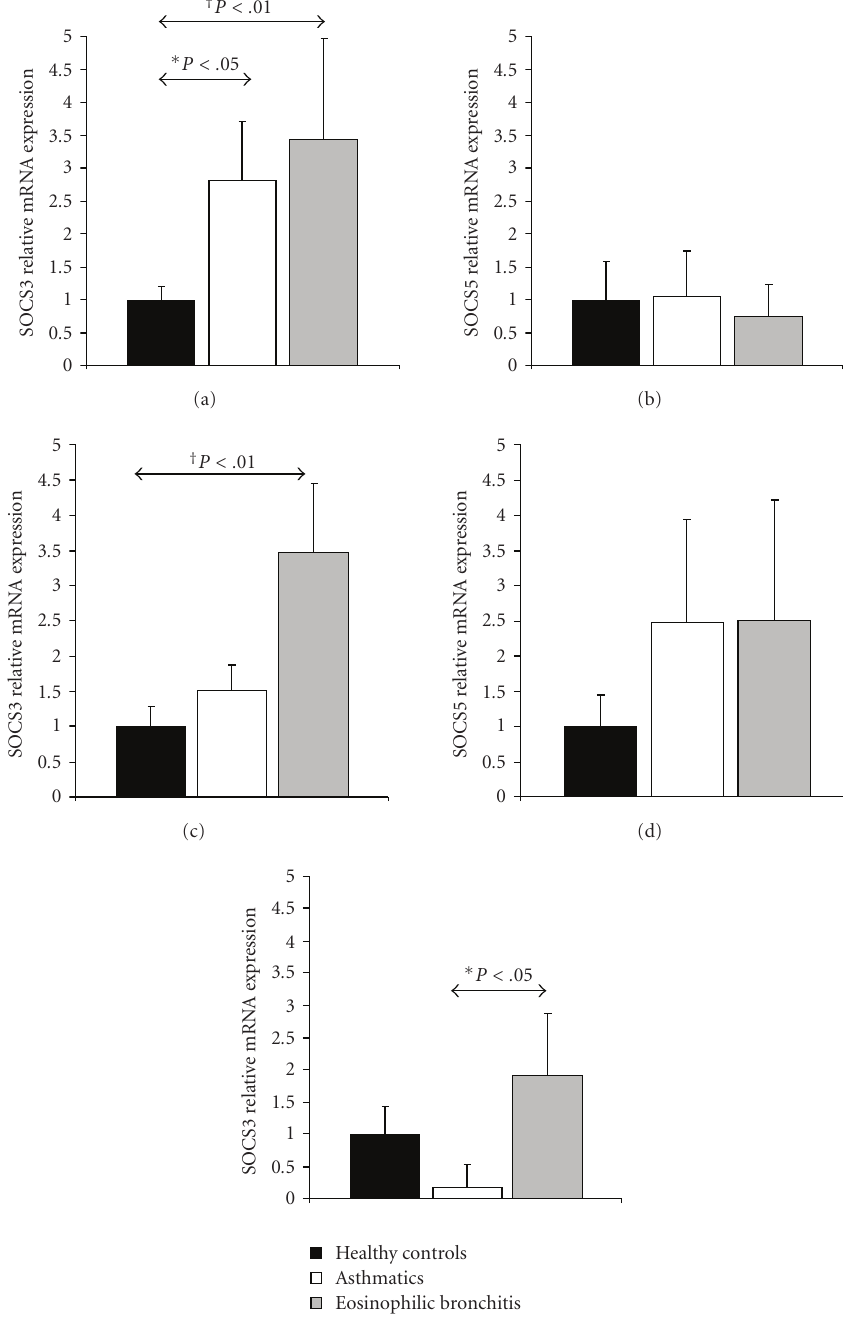
Figure 1: Semiquantitative expression of SOCS3 and SOCS5 genes in peripheral blood purified CD4 T cells and eosinophils. Relative mRNA levels of SOCS3 and SOCS5 in CD4 T cells ((a) and (b)), and eosinophils ((c) and (d)) of healthy controls, asthmatic and NAEB patients were determined by real-time quantitative PCR. Values were normalized with rRNA gene used as an endogen. Black boxes represent the healthy control group (mean ± SD, n = 9), white boxes represent the asthmatic patient group (mean ± SD, n = 6), and lineated boxes represent the NAEB group (mean ± SD, n = 8). Significant di ff erences in the levels of SOCS3 expression in CD4 T cells were obtained for asthmatic and NAEB patients versus the healthy control group ( ∗ P < . 05 and ∗∗ P < 0 . 01, resp.). In eosinophils, the SOCS3 level was significantly higher in NAEB patients than in healthy controls ( ∗∗ P < . 01) . In the case of SOCS5, no significant di ff erences were found between the groups. (e) SOCS3 mRNA levels in bronchial biopsies from healthy controls (mean ± SD, n = 2), asthmatics (mean ± SD, n = 2), and NAEB patients (mean ± SD, n = 4). Significant di ff erences in the levels of SOCS3 expression were obtained for asthmatic versus NAEB patients ( ∗ P < . 05) . The results represent relative gene expression, as determined by the ΔΔ C T